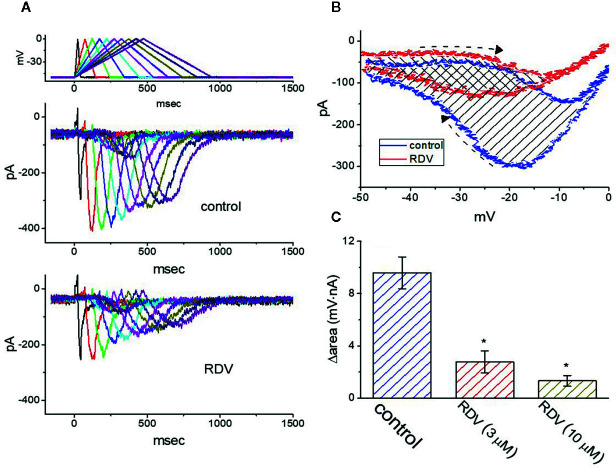
Effect of RDV on I
K(M) in response to isosceles-triangular ramp pulse with different durations (40–940 ms) which was particularly designed to mimic different depolarizing and repolarizing slope of bursting pattern. (A) Superimposed I
K(M) traces in response to the uppermost voltage protocol obtained in the absence (upper) and presence (lower) of 3 μM RDV. The uppermost part is the voltage profile delivered. (B) Effect of RDV (3 μM) on voltage dependent hysteresis (i.e., the relationship of forward and reverse current versus membrane voltage) of I
K(M) elicited by triangular ramp pulse with a duration of 940 ms. Blue or red current trajectory indicates the absence or presence of 3 μM RDV, respectively. Dashed arrows indicate the direction of I
K(M) in which time passes during the elicitation by 940-ms triangular ramp pulse. (C) Summary bar graph showing the effect of RDV on the Δarea (as indicated in shaded area in (B) (mean ± SEM; n=9 for each bar). The Δarea with respect to the voltage-dependent hysteresis of I
K(M) taken with or without 3 μM RDV addition is indicated as shaded area in (B). *Significantly different from control (P<0.05).